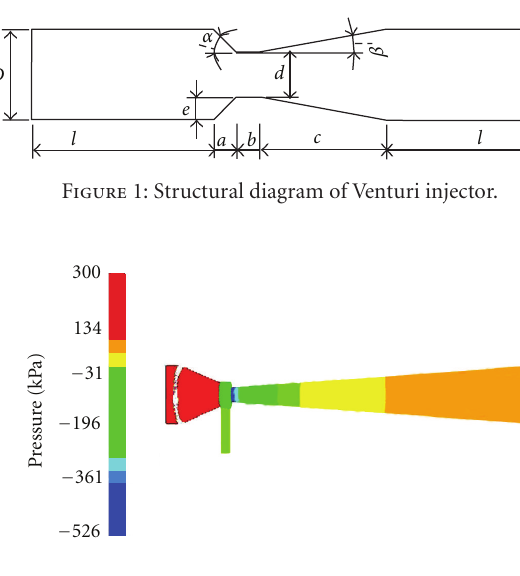
Figure 2: Pressure profile patterns of Venturi injector.